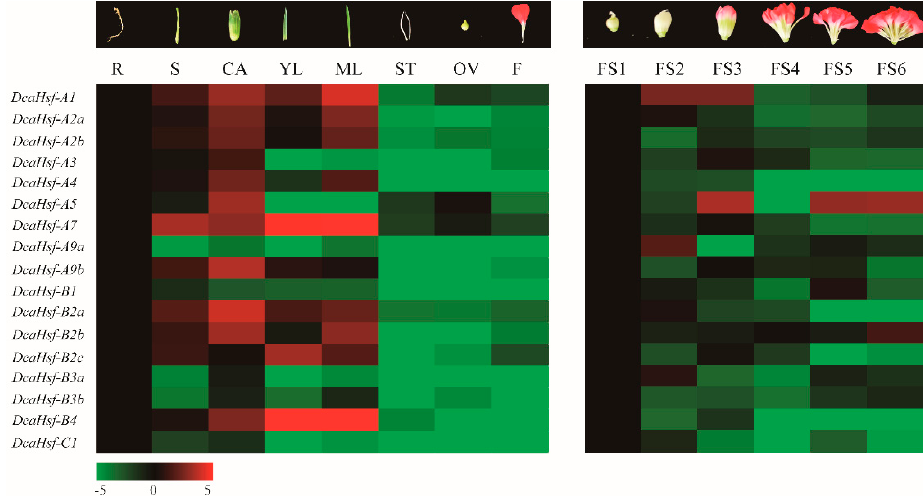
Figure 5. The expression levels of DcaHsfs in different tissues and flowering stages. The different colors correspond to log 2 -transformed fold change, green indicates down-regulation, and red represents up-regulation.